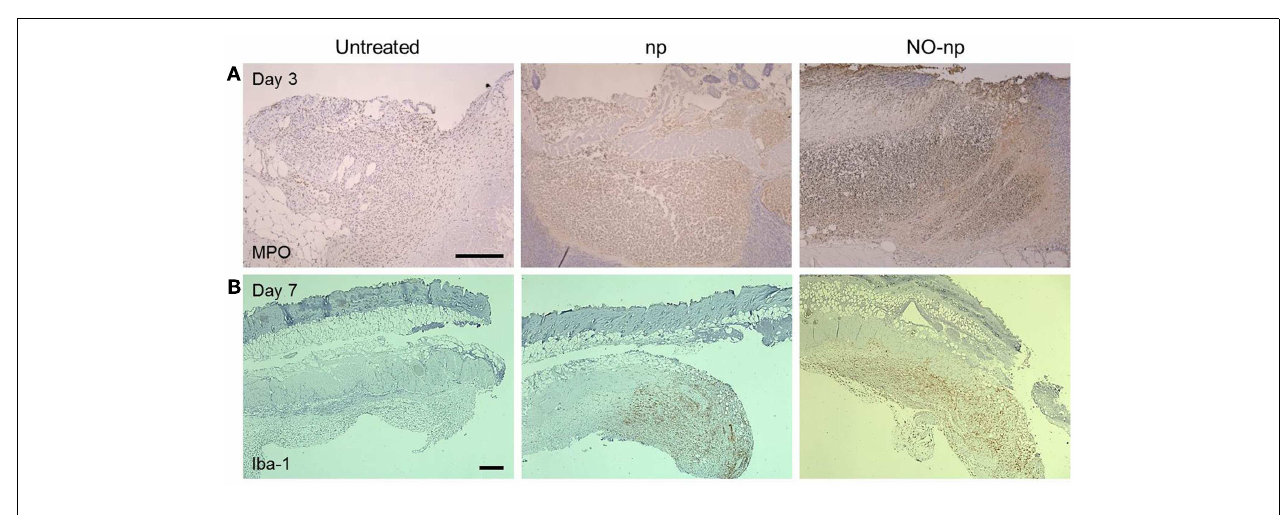
bars: 20 µ m. (B) Histological analysis of untreated, np-treated and NO-np-treated wounded Balb/c mice, day 7.The brown staining indicates macrophage-like cell infiltration. Representative Iba-1-immunostained sections of the skin lesions are shown. Scale bars: 25 µ